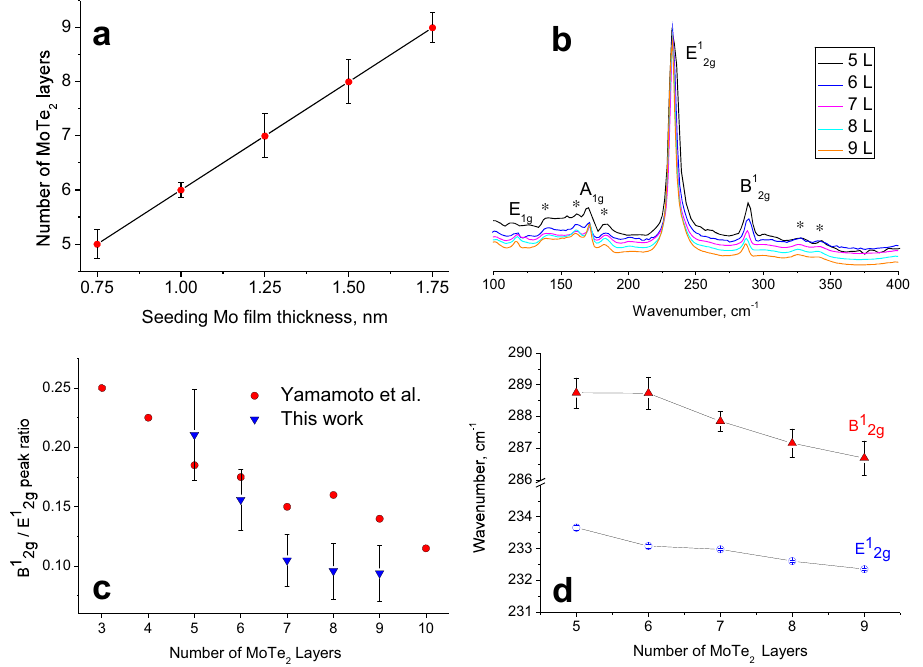
Fig. 3 The role of fi lm thicknesses on Raman spectra. The correlation between the thickness of the thermally evaporated Mo fi lm and the resulting few- layered MoTe 2 on 300 nm SiO 2 /Si substrate. Errors are based on n = 6 independent points ( a ); 532 nm Raman spectra depending on number of layers in few-layered 2H-MoTe 2 on 300 nm SiO 2 /Si substrates. The spectra are shifted along y -axis for clarity. The modes associated with 2H-MoTe 2 are labelled and second-order peaks are marked with asterisk ( b ); Raman data assessment of B 1 2g /E 1 2g ratio for MoTe 2 fi lms on 300 nm SiO 2 /Si depending on the number of layers (blue triangles). The data (red circles) for exfoliated MoTe 2 samples adopted from ref. 38 . are plotted for comparison. Errors are based on n = 15 independent points ( c ); Raman data assessment of the positions of B 1 2g and E 1 2g peaks depending upon the number of layers. Errors are based on n = 15 independent points ( d